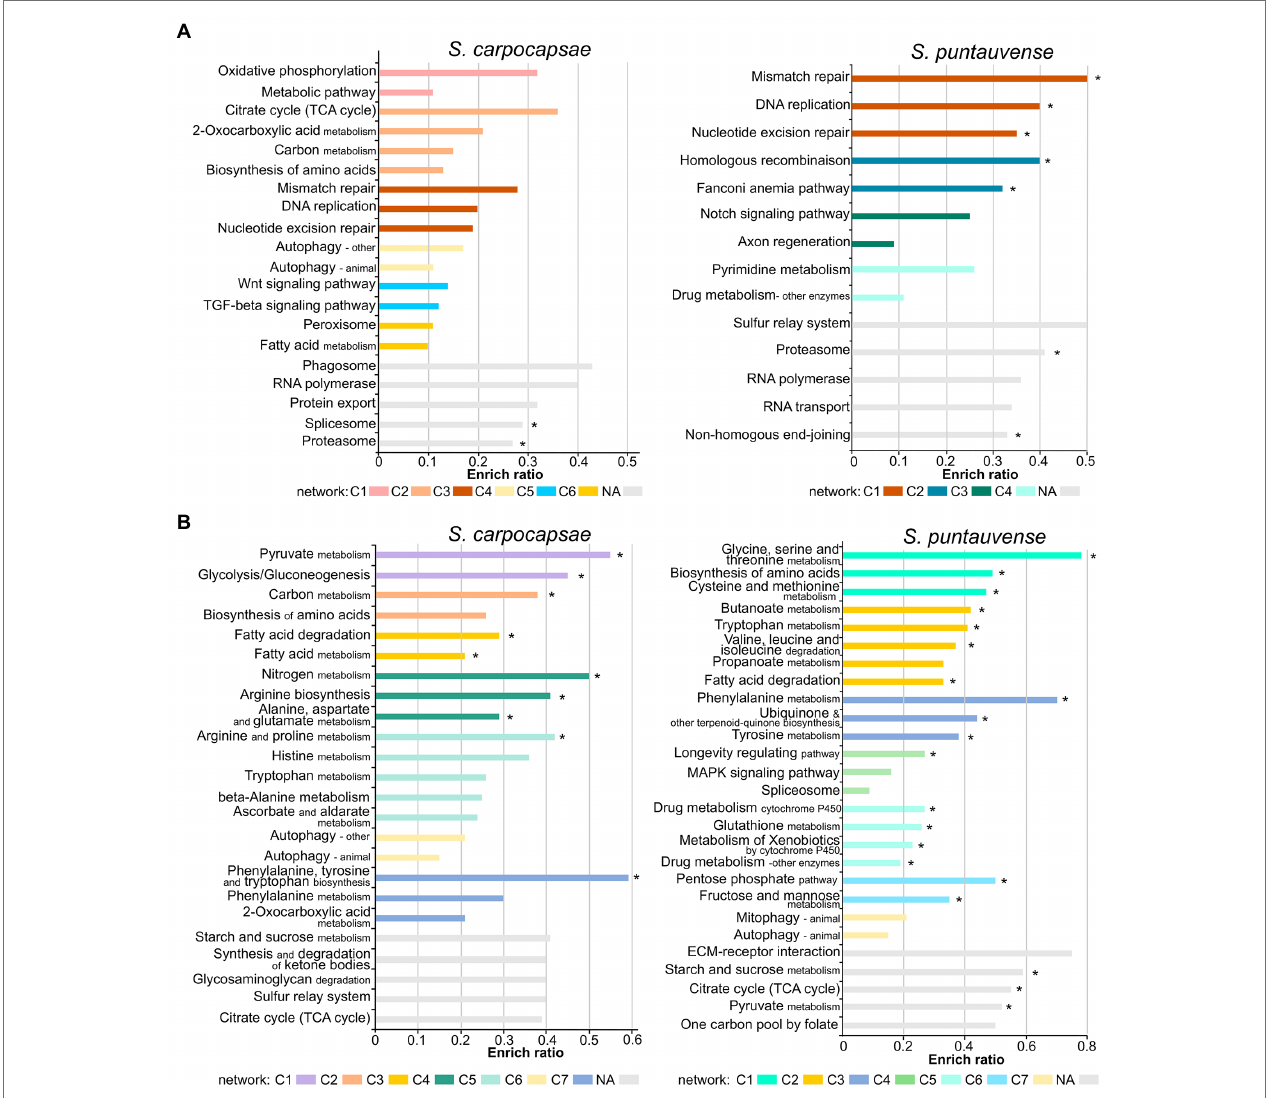
FIGURE 2 | Barplot of enriched KEGG ratio of differentially expressed transcripts in in vitro aposymbiotic reared IJs when compared to in vivo reared IJs using i-KOBAS. The length of the bar represents the enrich ratio calculated as “input gene number”/ “backgound gene number.” The color of the bar represents network of protein representing modules identified by i-KOBAS based on Caenorhabditis elegans dataset. For networks where numerous modules are enriched only the top five are displayed. The “*” indicates enriched KEGG terms identified for both in vitro aposymbiotic and colonized reared IJs. (A) Enriched KEGG ration of upregulated transcripts. (B) Enriched KEGG ratio of downregulated